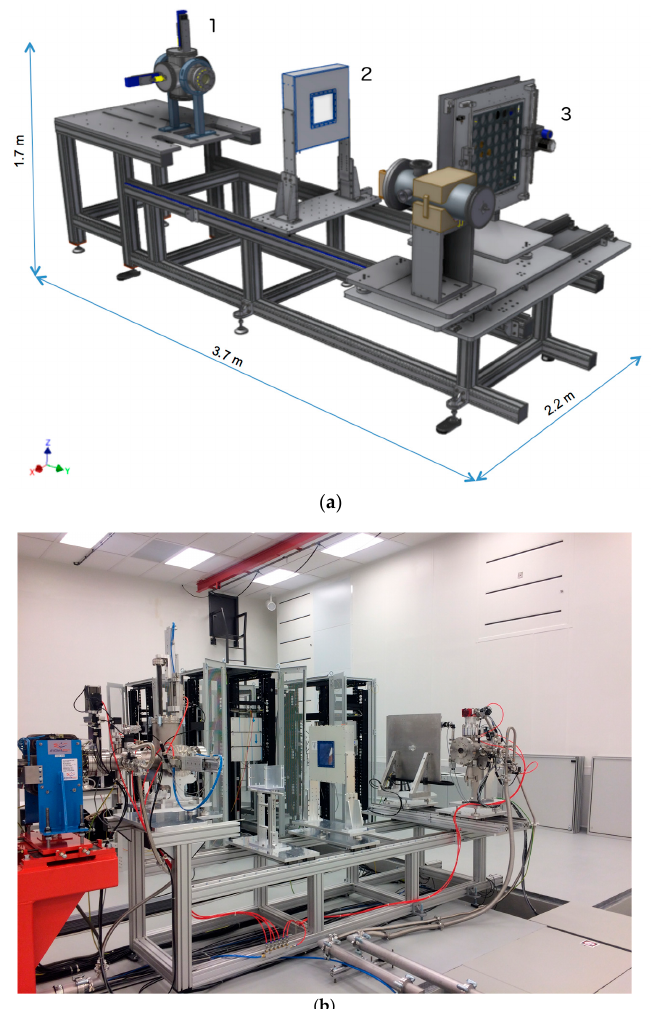
Figure 6. ( a ) 3D model of the in-air final section of the ELIMAIA beam line. Transported particles come from the left: (1) flange, separating the two sections of the beamline and housing the secondary emission monitor (SEM) and TOF detectors. (2) Ion collector (IC) for the in-transmission dose monitoring. (3) Final irradiation point, including the Faraday cup (FC) and sample irradiation system (SIS), respectively, used for absolute dosimetry and sample irradiation. All the elements are installed in translating stages to change their relative position; ( b ) picture of the in-air final section for dosimetry and sample irradiation installed along the ELIMAIA beamline.